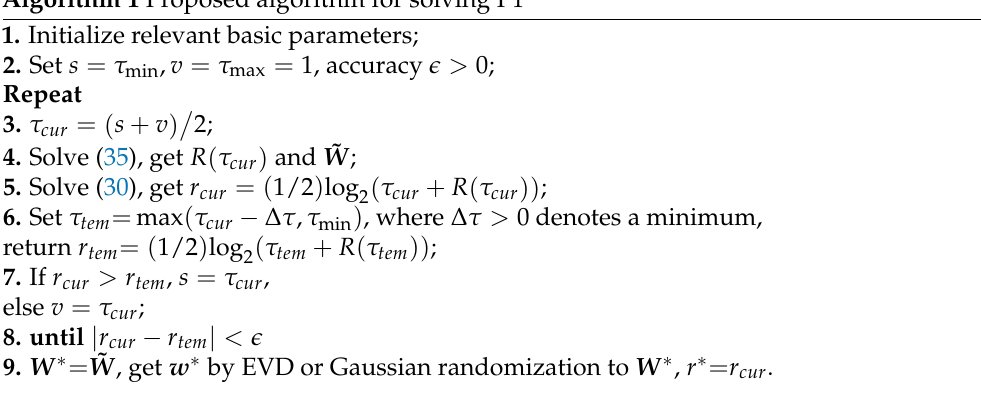
Algorithm 1 Proposed algorithm for solving